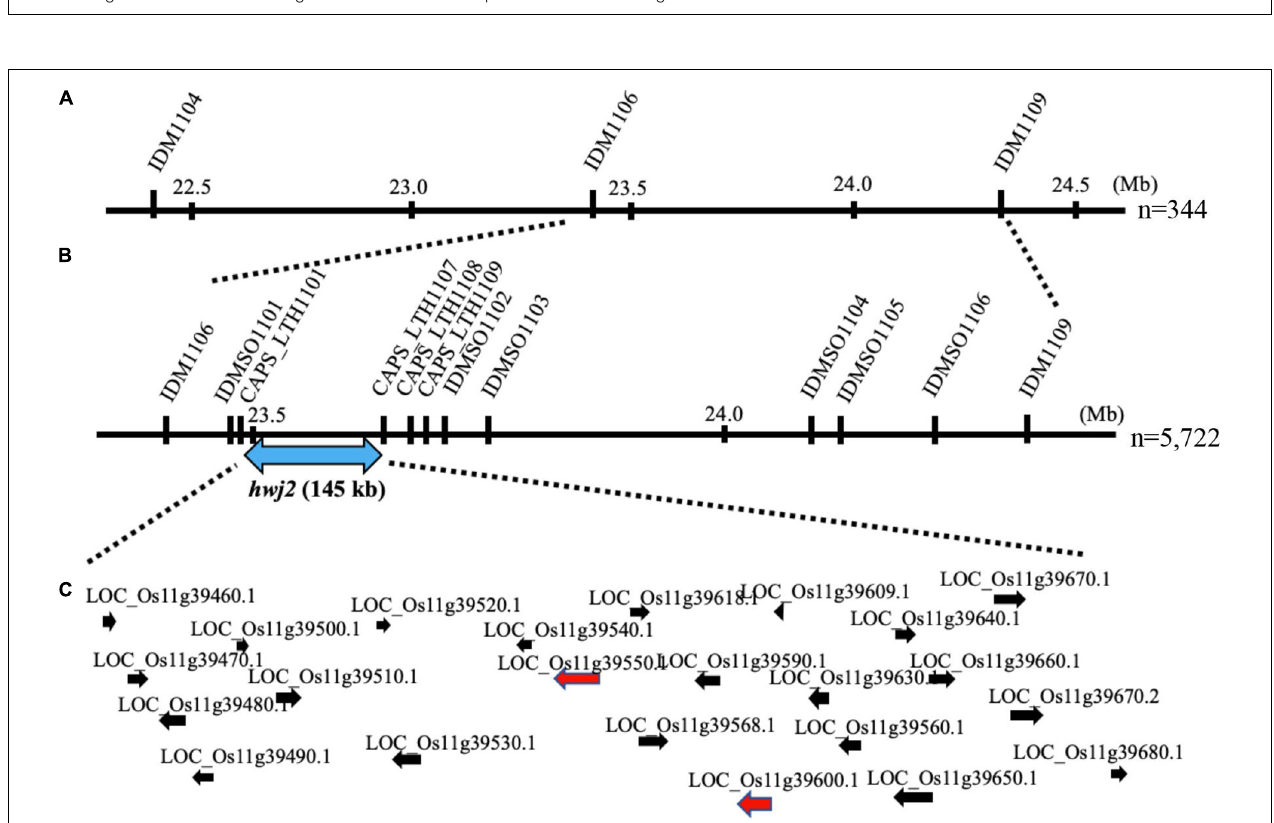
FIGURE 6 | Fine mapping of the hwj2 locus. (A) Initial mapping of hwj2 on chromosome 11. Numbers show physical positions in megabase (Mb), (B) fine mapping of hwj2 . The hwj2 locus was delimited between flanking markers CAPS_LTH1101 and CAPS_LTH1107. Blue-double head arrow shows the candidate region, and (C) annotated genes in the candidate region. The red arrows represent NB-LRR disease-resistance gene and disease resistance-related gene. The black arrows represent other annotated genes.